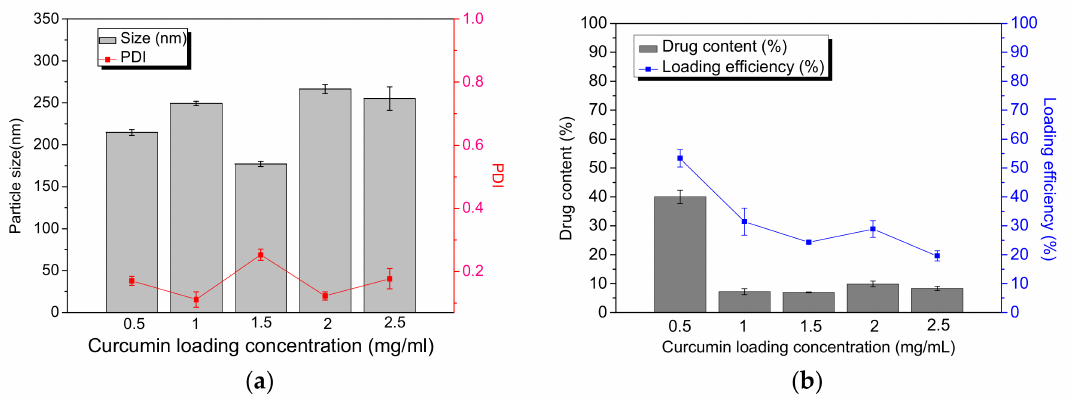
Figure 4. Drug-loading of curcumin-loaded PECs. Curcumin was prepared at various concentrations in alcohol. The curcumin alcoholic solution was mixed with type B gelatin and pectin, forming PECs at pH 4.0. The particle size and PDIs ( a ) of curcumin-loaded PECs were determined by DLS. To